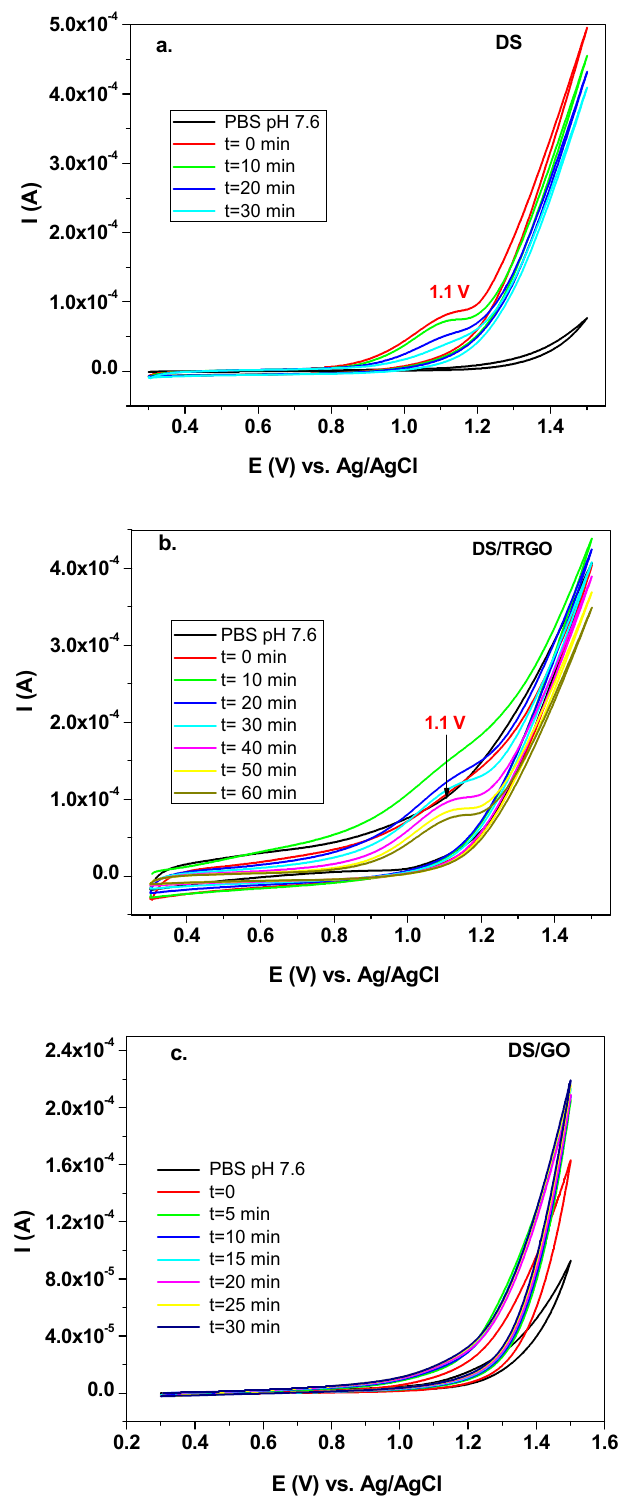
Figure 4. CVs recorded at different accumulation time with bare DS ( a ), DS/TRGO ( b ), and DS/GO ( c ) in the presence of 0.07 mg/mL CA199-His in pH 7.6 PBS solution; 10 mV/s scan rate . A maximum peak current of 1.9 × 10 − 5 A was reached in 10 min for the bare DS electrode, as can be seen in Figure 5 (red curve). After that period of time, I peak significantly decreased due to the saturation of the surface with CA199-His molecules that block the transfer of electrons from the neighboring molecules. A different situation was observed in the case of the DS/TRGO electrode,